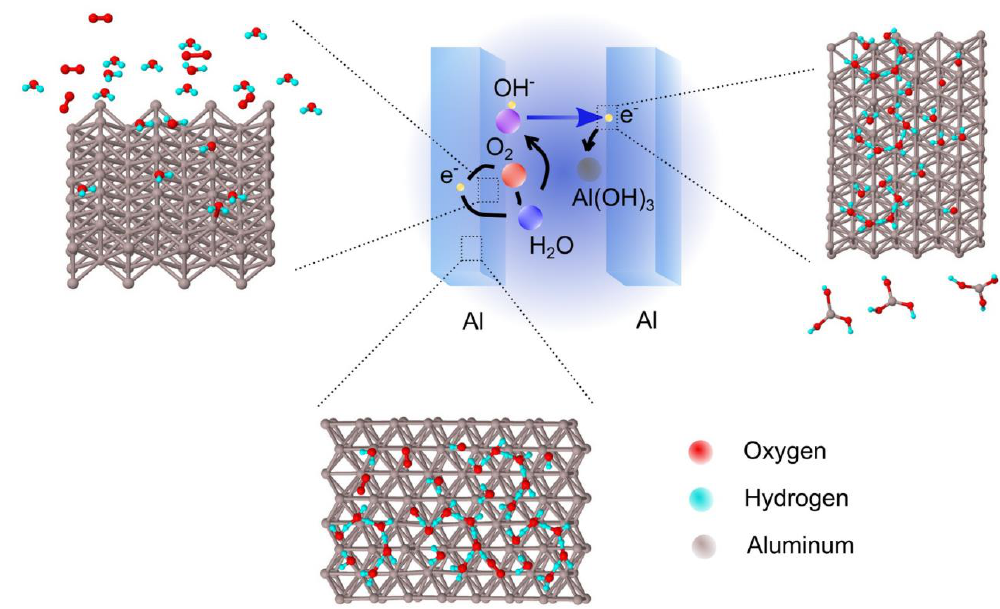
Figure 7. Illustration of the electrochemical process described by Equations (1)–(3). Incoming electrons on one of the electrodes will take part in the reaction between water and oxygen. As a result of this reaction, the hydroxyl group (OH − ) is formed and diffuses through the water until it reaches the opposite electrode. At the opposite electrode, the hydroxyl group reacts with aluminum, thus forming aluminum hydroxide. At the same time, electrons are released on the aluminum electrode. The electrons drift through outer circuitry. Images of aluminum crystal lattice and molecules were generated using the software Jmol [45].